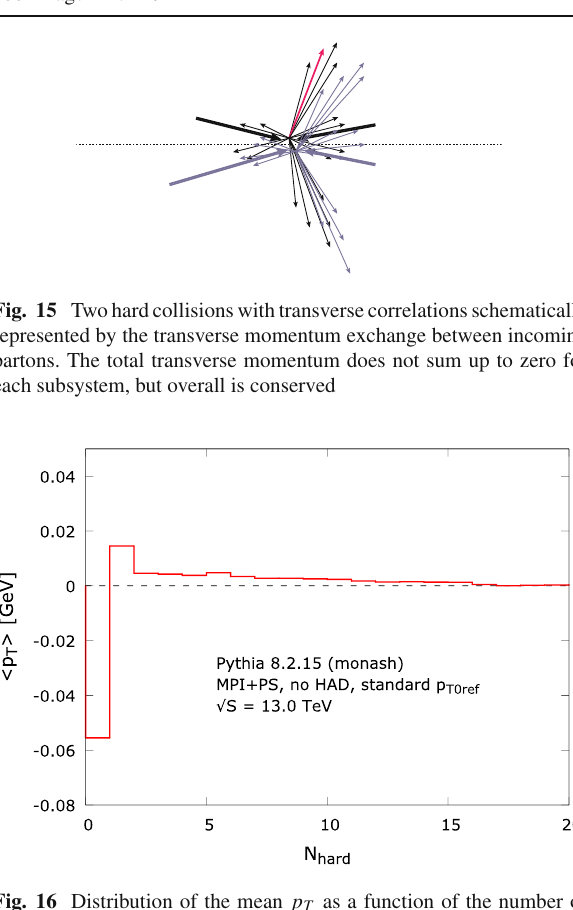
Fig. 16 Distribution of the mean p T as a function of the number of parton interaction in Pythia . Although the total transverse momentum is conserved, the subsequent hard collisions posses a slights transverse imbalance due to the primordial k T mechanism